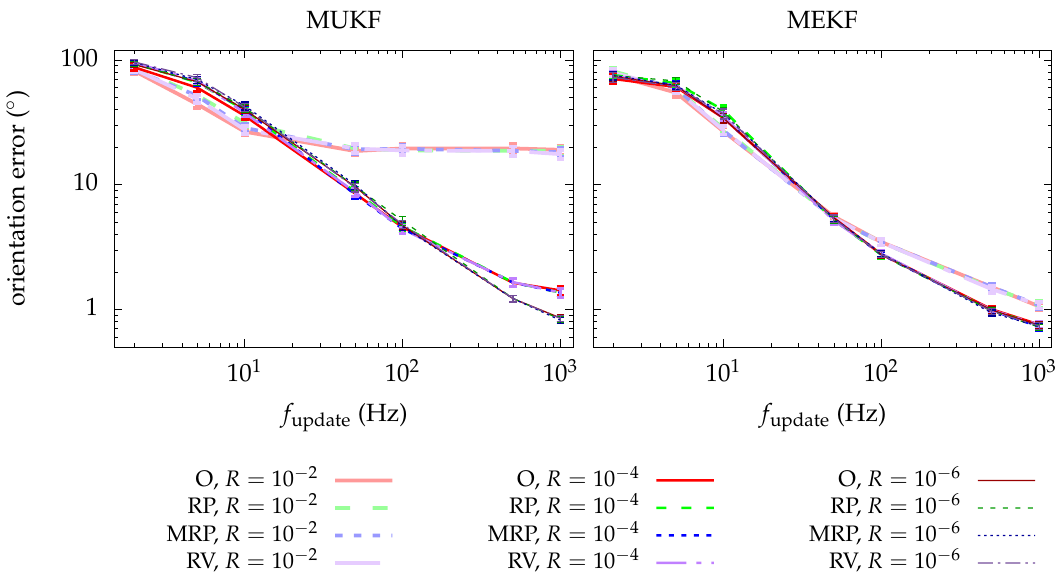
Figure 5. Mean of the performance metric for each approach. Results from different charts are plotted in the same graph. Results from different MKF are plotted in different graphs. Bars represent the confidence interval (3 σ ) for the mean computation.